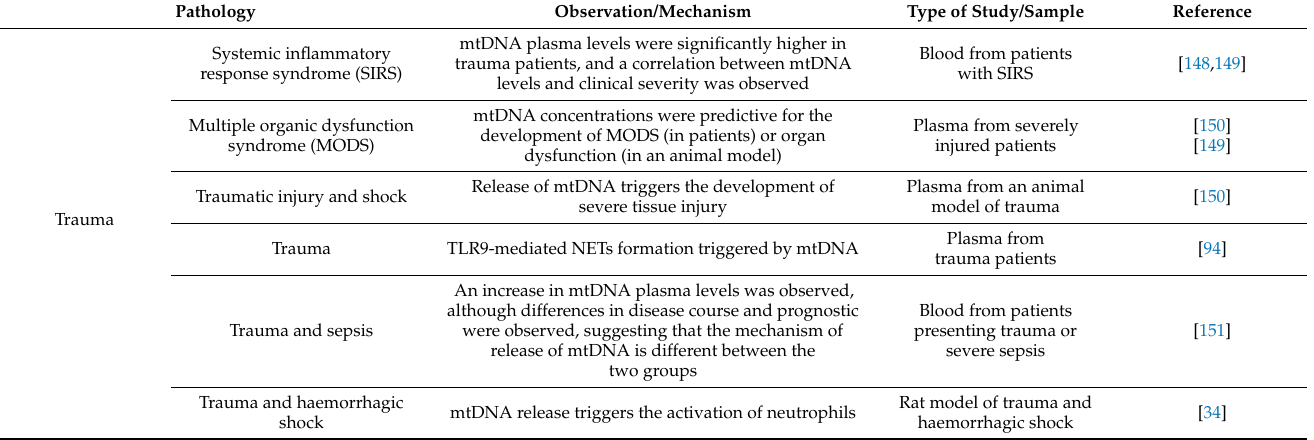
Table 1. Role of mtDNA as inflammatory molecules in human pathologies described in this review.